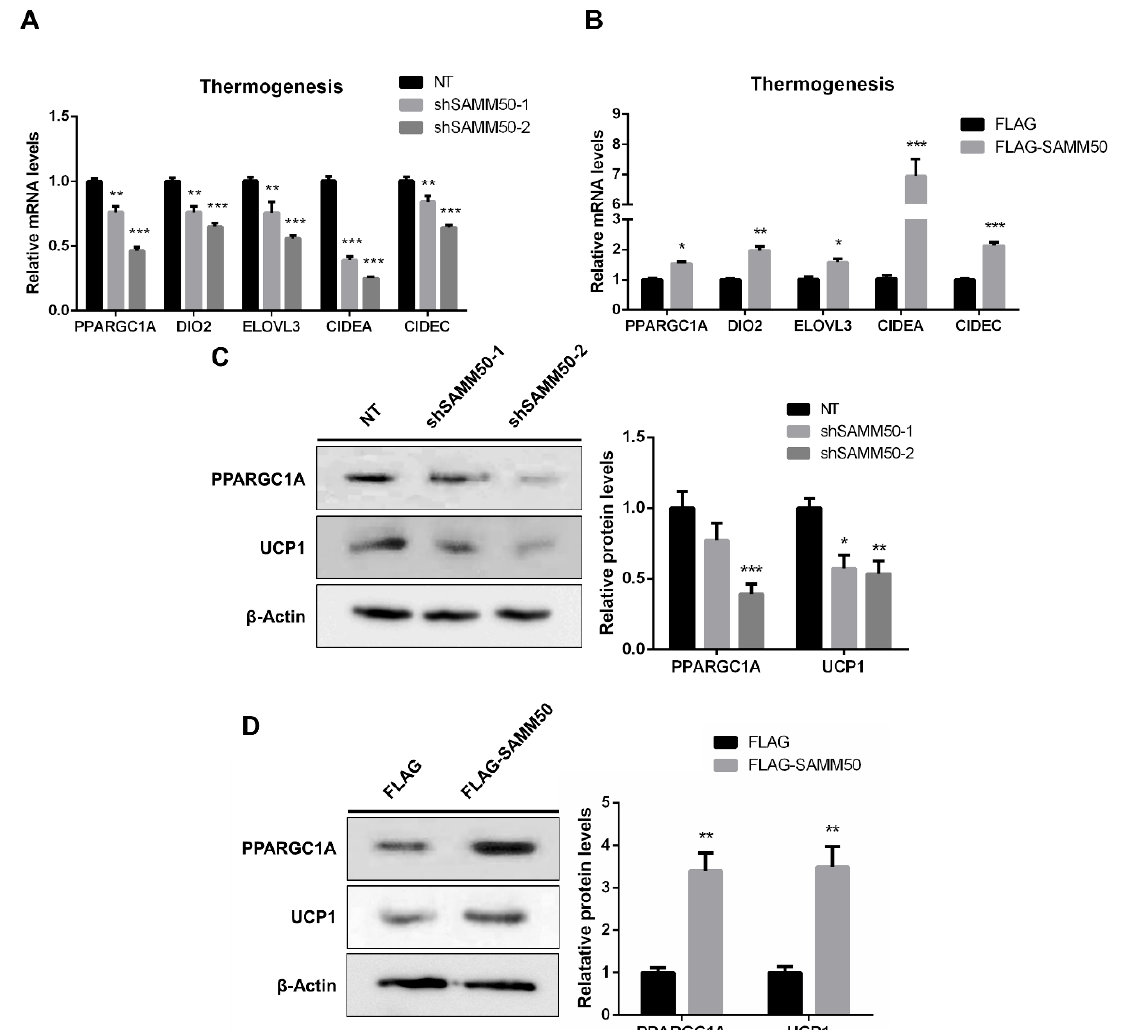
Figure 6. The effects of SAMM50 knockdown and overexpression on the thermogenesis of beige adipocytes. ( A , B ) The expression levels of thermogenic genes in beige adipocytes infected with shSAMM50 ( A ) and FLAG-tagged SAMM50 ( B ) were analyzed by qPCR analysis. ( C , D ) Western blot analysis was performed to determine the protein levels of PPARGC1A and UCP1 in the shSAMM50 ( C ) and FLAG-tagged SAMM50 ( D ) -infected beige adipocytes. The protein levels of PPARGC1A and UCP1 were quantified using ImageJ software. Results are shown as mean ± SEM. * p < 0.05; ** p < 0.01; *** p < 0.005 compared to the controls.